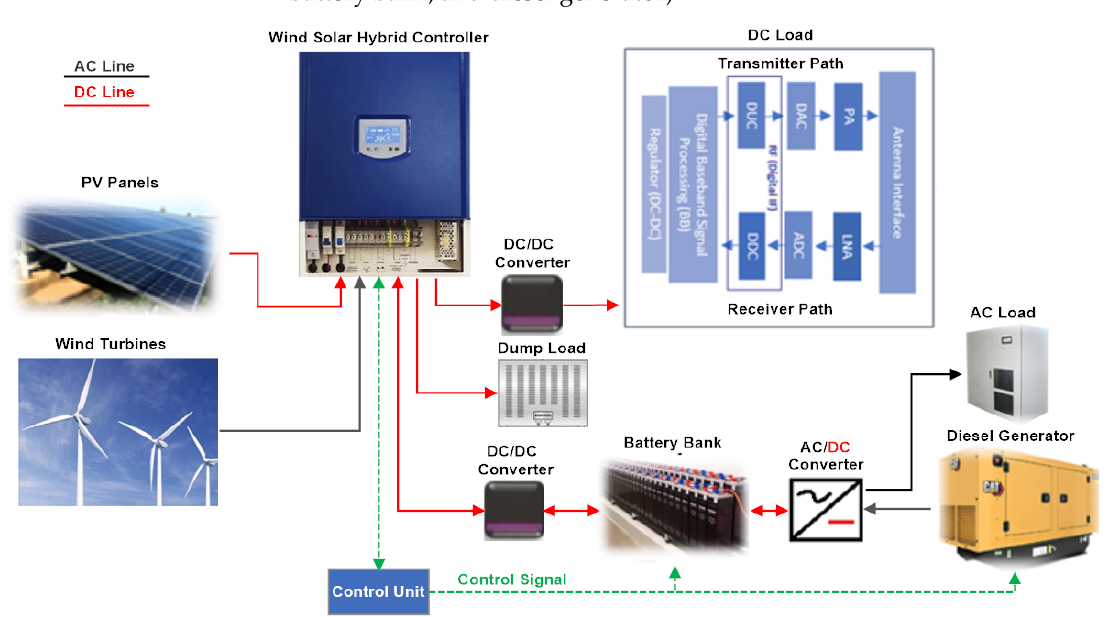
Figure 3. Schematic of the proposed hybrid PV/wind electric